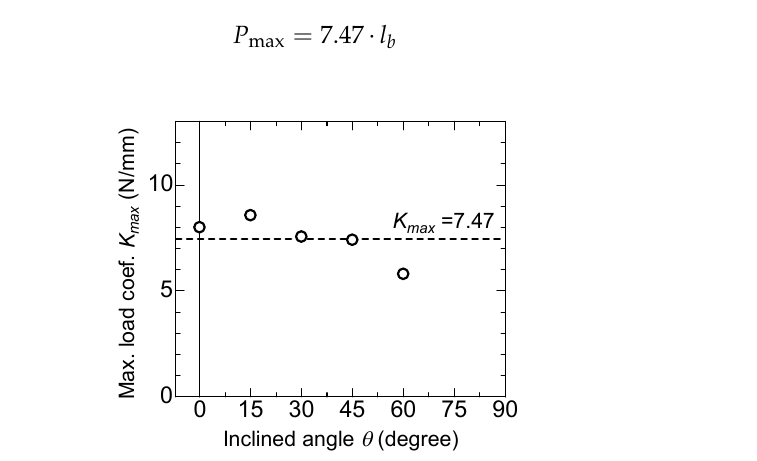
Figure 11. Maximum load coefficient versus inclined angle.